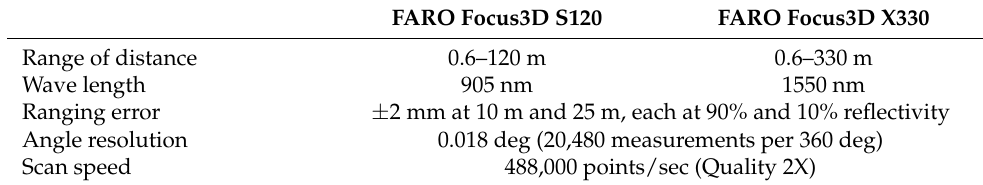
Table 2. Specifications and settings of laser